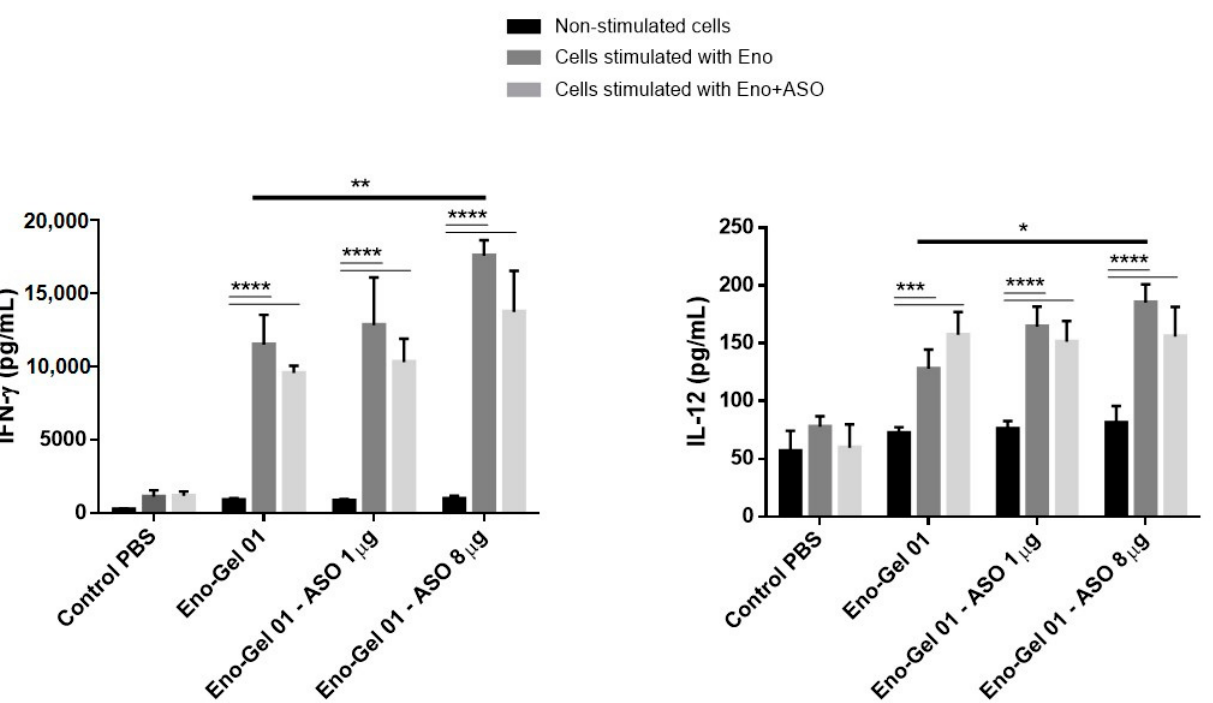
Figure 7. IFN- γ and IL-12 cytokines in the spleen. The spleen cells were extracted on day 21, then incubated for 48 h with Eno of S. schenckii or with Eno+ ASO anti-Foxp3. The cytokines IFN- γ and IL-12 were evaluated by means of ELISA. A one-way analysis of variance (ANOVA) with Tukey’s post hoc test was used. The confidence interval was established at 95% for all tests. The level of significance and p values are shown as * ( p < 0.05); ** ( p < 0.01); *** ( p < 0.001); **** ( p < 0.0001).